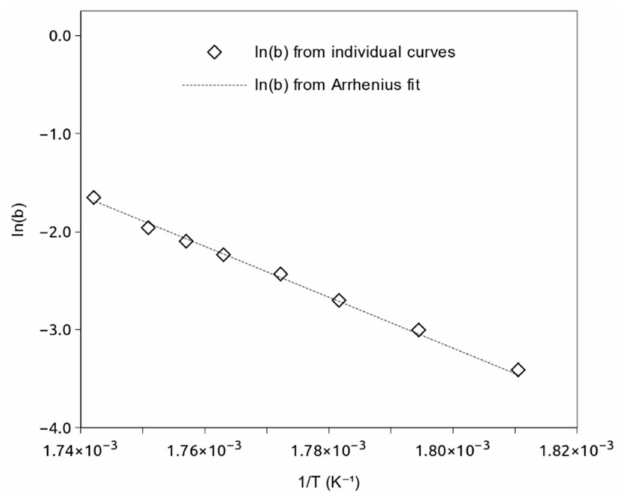
Figure 6. Plot of ln( b ) versus 1/ T